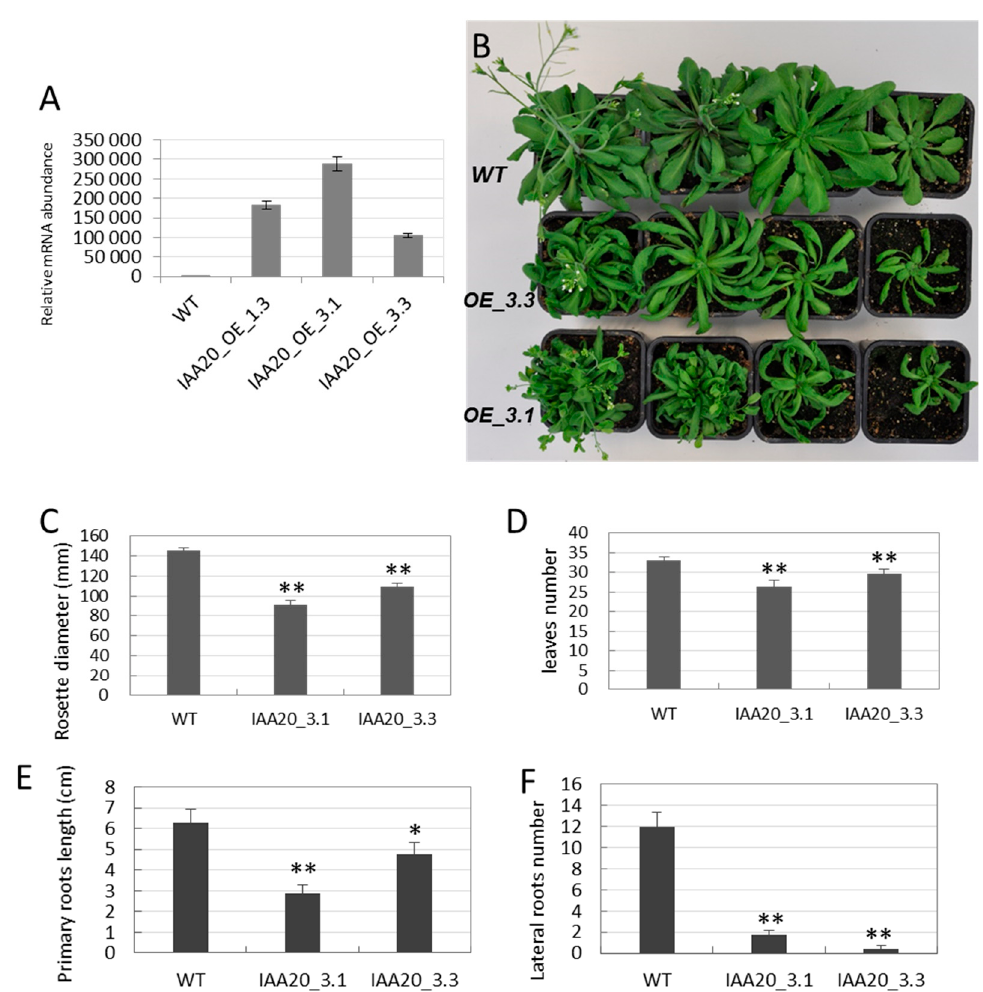
Figure 4. EgrIAA20 overexpressing lines displayed reduced rosette development with helical twisting leaves and reduced root development. ( A ) EgrIAA20 mRNA accumulation in three phenotypically representative independent transgenic lines. The EgrIAA20 overexpressing lines ( IAA20_OE_3.1 and IAA20_OE_3.3 ) presented reduced rosette development with helices twisting and backward rolling leaf blades and reduced leaf size ( B ), significantly reduced diameter of rosette ( C ), significantly reduced leaves number ( D ), significantly reduced primary root length ( E ), and greatly reduced lateral roots number ( F ). Error bars represent standard error. Asterisks indicate values found to be significantly different from the wild-type control (Student’s t -test, n > 10); ** indicates p < 0.01, and * indicates p < 0.05.